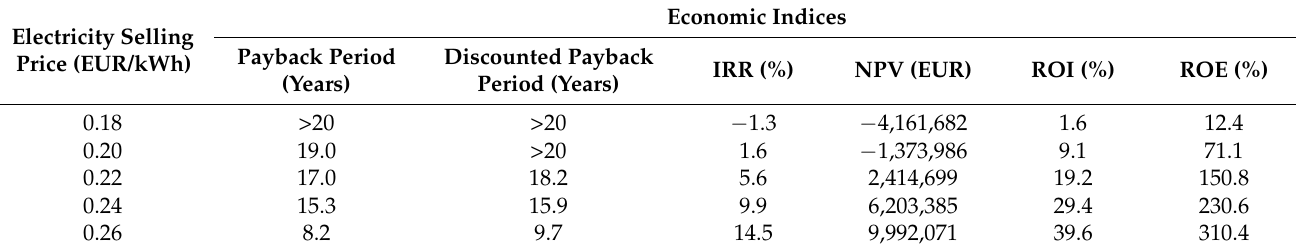
Table 5. Impact of the electricity selling price on the investment’s economic